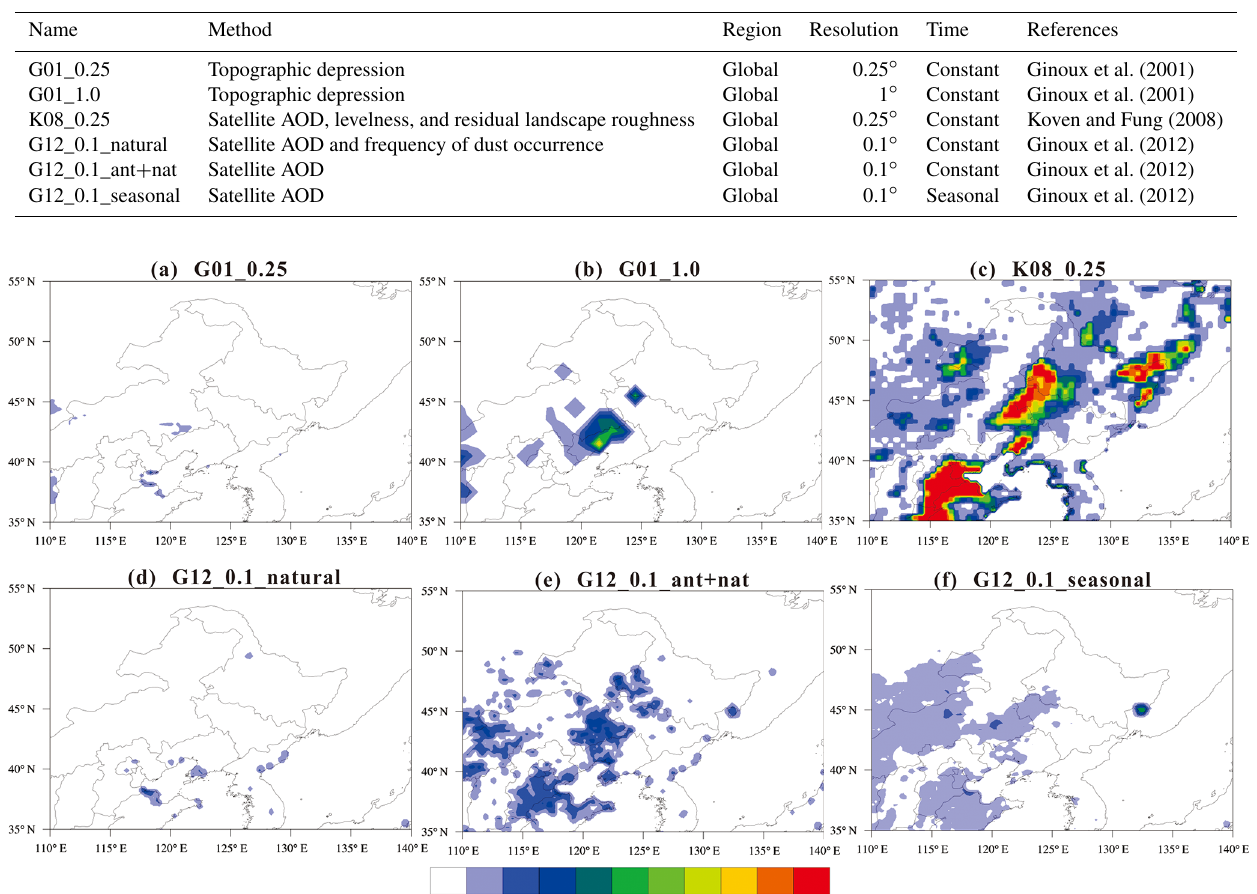
Table 2. Information on dust source maps used in WRF-Chem.